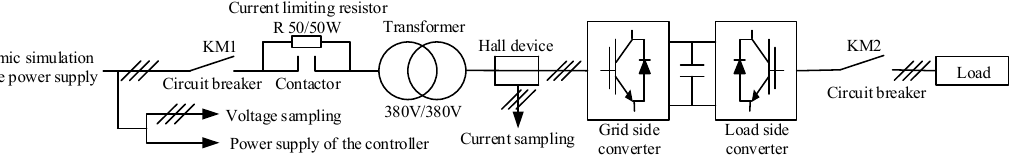
Figure 14. Physical prototype.